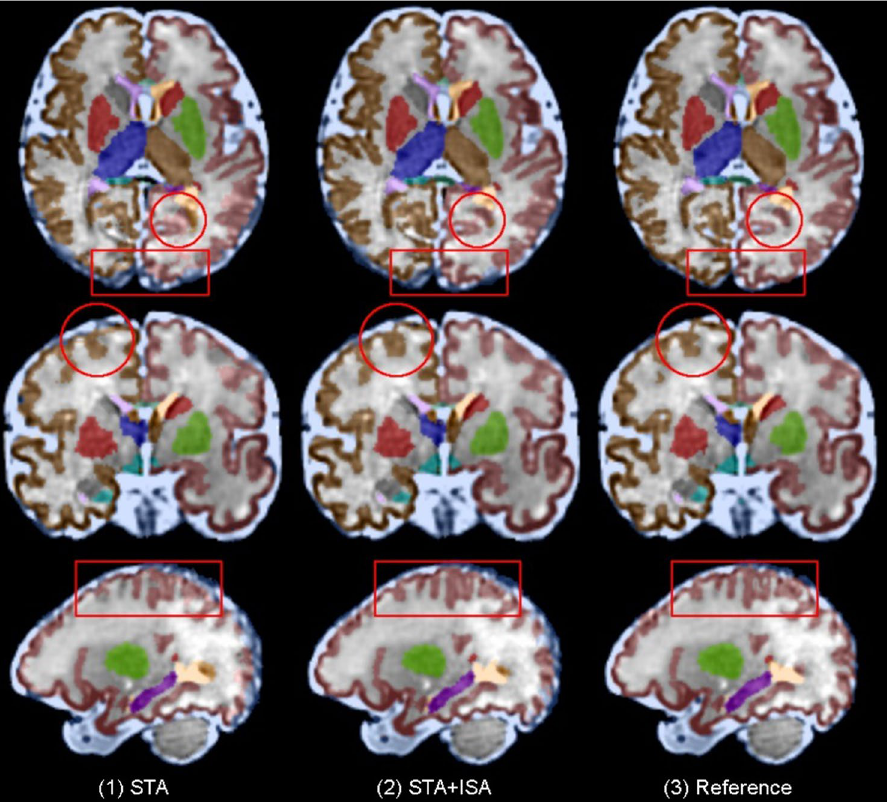
Figure 7. Visual assessment and comparison of atlas-based segmentation of fetal brain MRI using multiple atlases: (1) segmentation using the spatiotemporal fetal brain MRI atlas (STA), (2) segmentation using the combination of the spatiotemporal atlas and individual-subject atlases (STA + ISA), and (3) reference standard. The circles and squares point at some of the areas in which the methods performed differently. Overall the results were satisfactory. As expected due to the use of a larger number of atlases, slightly better performance was observed for STA + ISA. For quantitative comparison of methods (STA and STA + ISA) we relied on the analysis of average DSC metrics reported in Table 1. Labels that are visible on these images are CSF, corpus callosum, developing white matter, and left and right cortical plates, ventricles, thalami, hippocampi, amygdalae, and caudate nuclei.